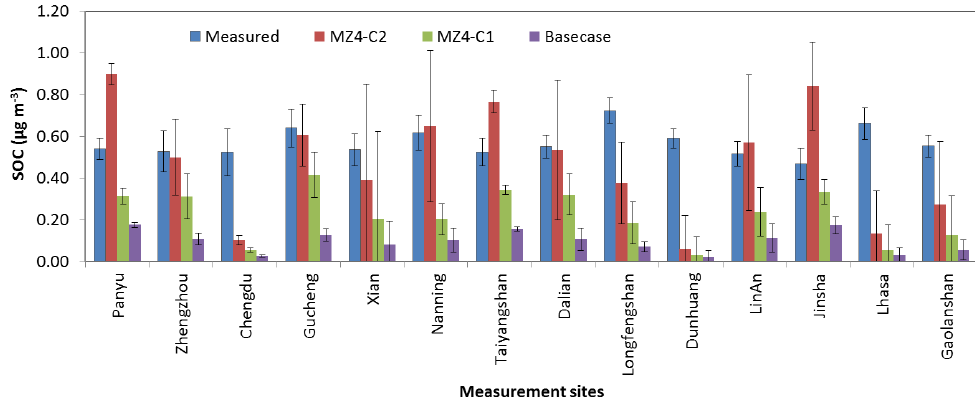
Fig. 7. Measured vs. modeled comparison of secondary organic carbon (SOC) at various measurement sites in China. Measured data were obtained from Zhang et al. (2012).